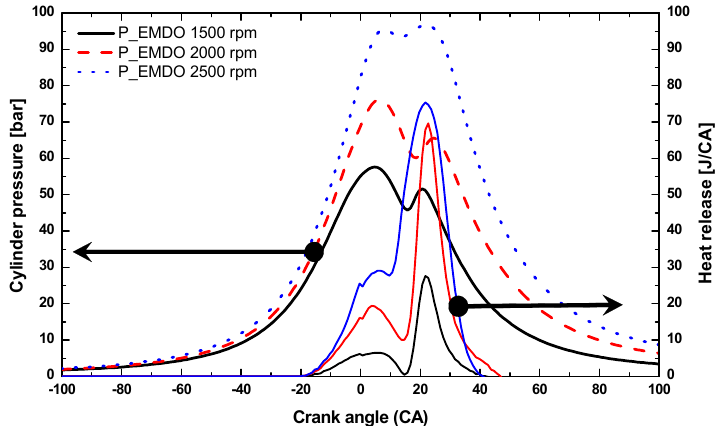
Figure 3. Characteristics of the cylinder pressure and heat release according to rpm for emulsified marine diesel oil (EMDO).